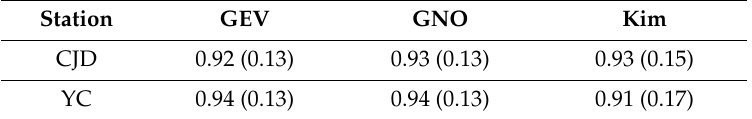
Table 3. CE and RMSNE statistic for the estimation of flood